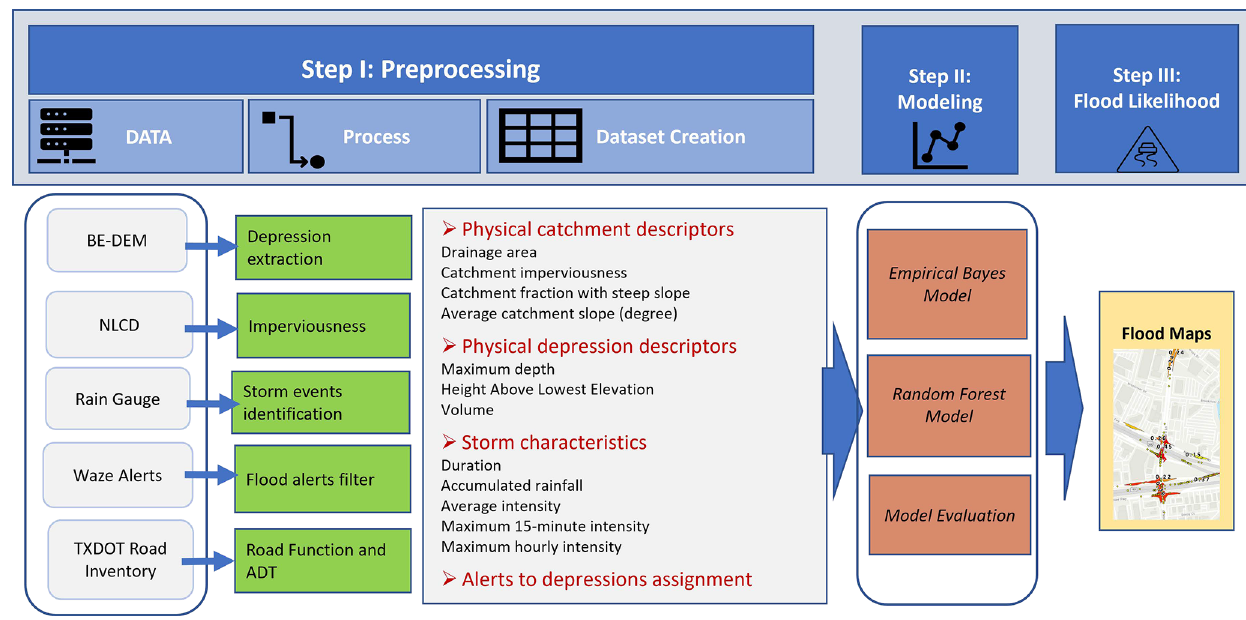
Figure 1. Methodology framework (basemap from ESRI-2021).